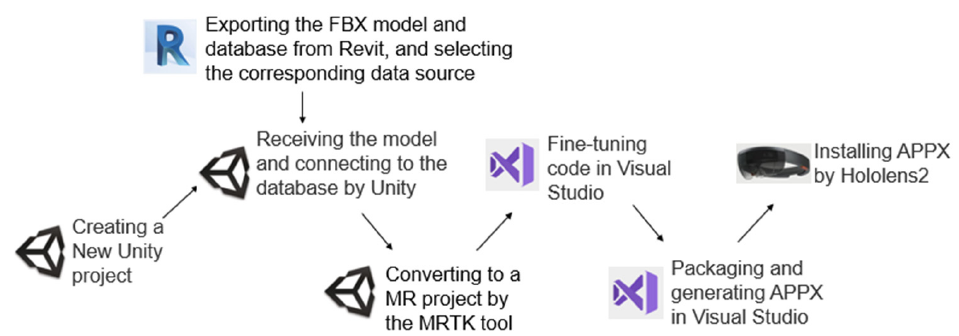
Figure 11. Data interaction flow between BIM and MR.